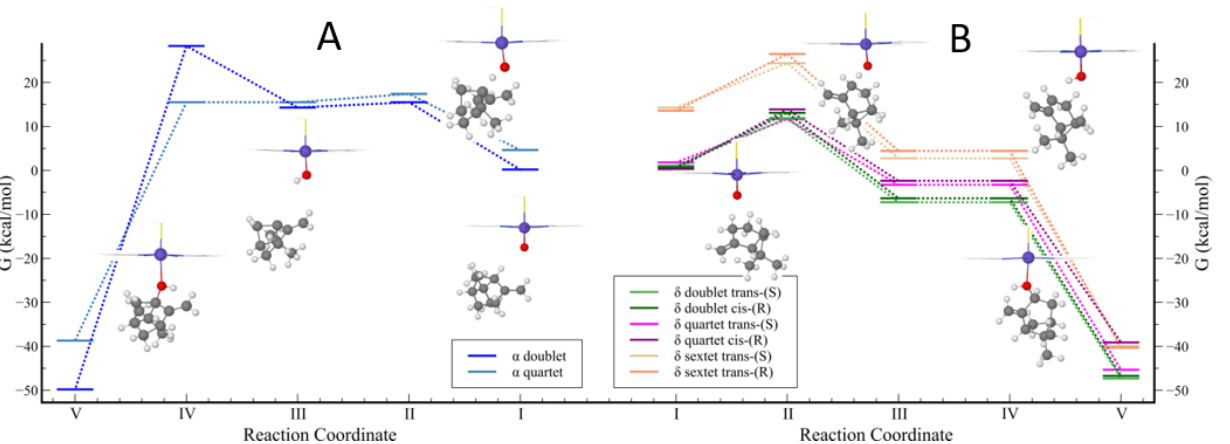
Figure 4. Reaction coordinates for the Gibbs free energies from the hydrogen abstraction and rebound mechanism of the β -pinene catalyzed by the CYP enzyme; ( A ) alpha and ( B ) delta. Data are provided in kcal/mol and relative to the alpha site reactant, the most stable structure in coordinate 1. The optimized structures of doublet alpha and delta trans-(S) paths are displayed in this figure. Table 4. Thermodynamic and kinetic data computed for the hydrogen capture reaction by CYP in β - pinene. The terms Δ r E, Δ r H, and Δ r G refer to electronic, enthalpic, and Gibbs free energy variation in the reaction, respectively. The terms ΔE ‡ , ΔH ‡ , and ΔG ‡ refer to the electronic, enthalpic, and Gibbs free energy reaction barriers, respectively, and the term “cor” refers to the dispersion, BSSE, and Grimme quasi-harmonic corrections to the calculated absolute Gibbs free energies. Hyd Δ r G cor refers to the hydroxylation free energies computed as the difference between the hydroxylated product and the reactant in coordinate 1. Data are displayed in kcal/mol.